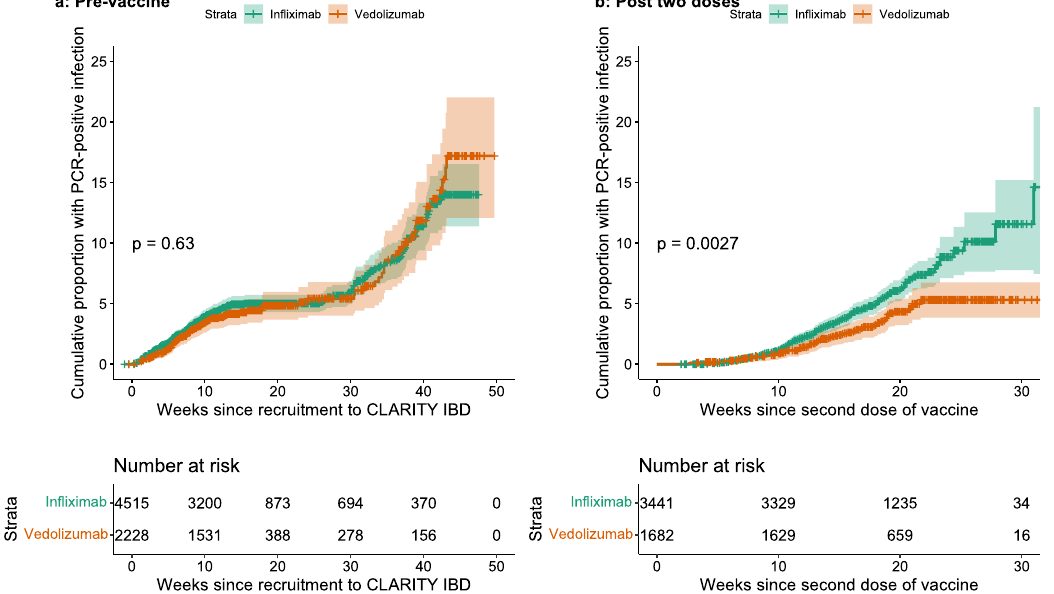
Fig. 6 Kaplan – Meier graphs comparing the time to PCR-con fi rmed SARS-CoV-2 infection strati fi ed by biologic therapy (in fl iximab vs vedolizumab) in participants before vaccination and after receiving two doses of vaccine. a The time to PCR-con fi rmed SARS-CoV-2 infection in participants who have not received any dose of either vaccine strati fi ed by biologic therapy (in fl iximab vs vedolizumab). b The time to a PCR-con fi rmed SARS-CoV-2 breakthrough infection in participants following two doses of either vaccine strati fi ed by biologic therapy. The biologic treatment in fl iximab is shown in green and vedolizumab in orange. The number of participants at each time point are displayed in black at the bottom of each fi gure. P values are calculated using the log-rank test. Source data are provided as a Source Data fi